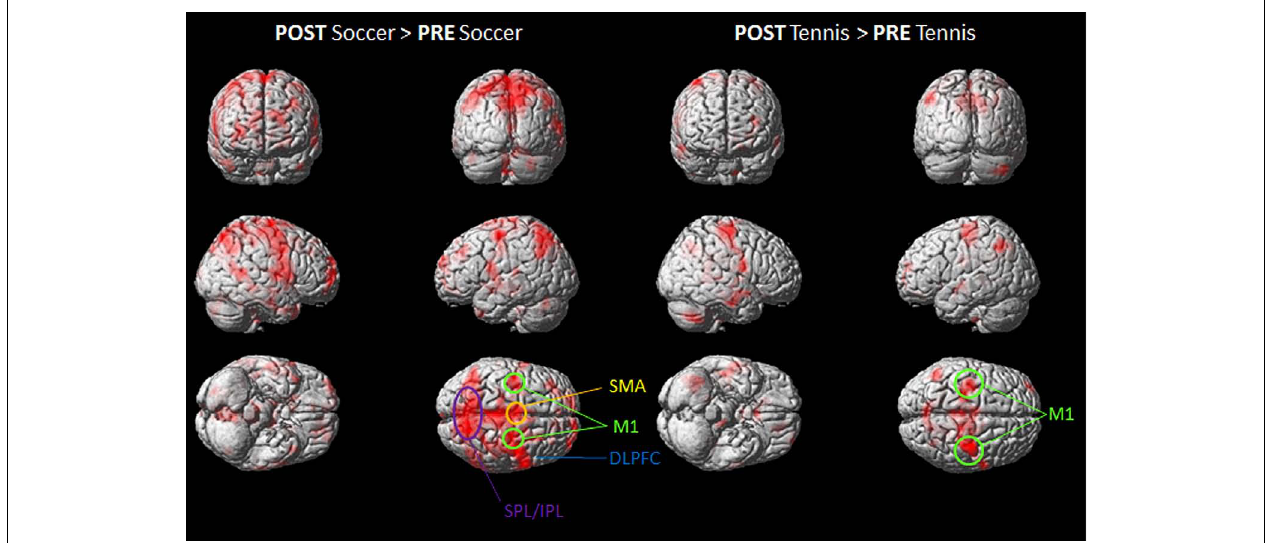
FIGURE 4 | Group activation maps showing activated brain regions in condition “POST Soccer > PRE Soccer (left side) and POST Tennis > PRE Tennis (right side).” All regional activations above initial significance threshold P < 0.05 (FEW corrected) and extent ( k E ) of 30